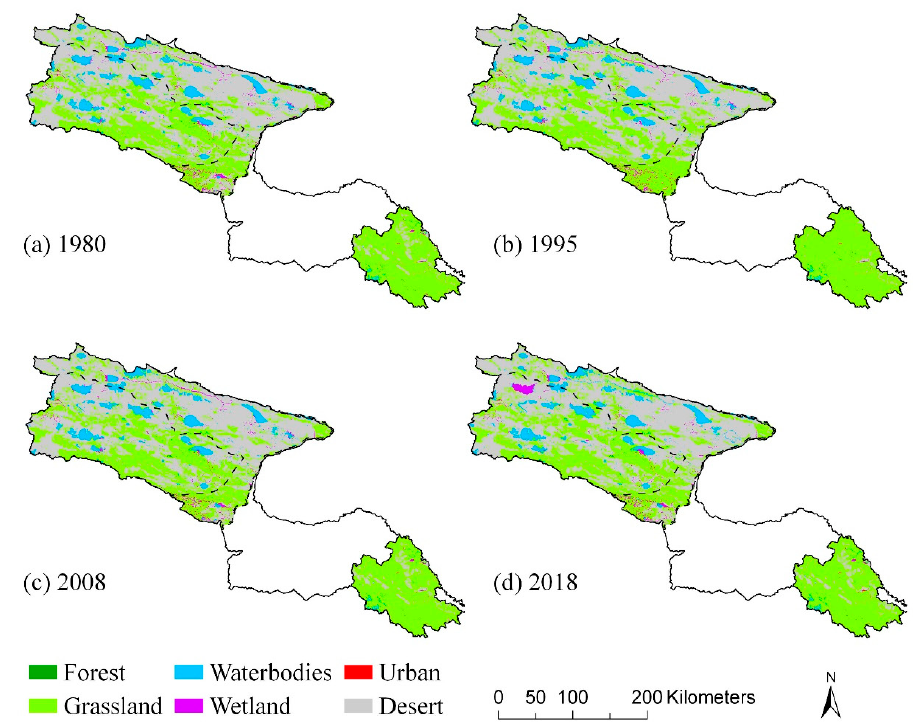
Figure 2. Comparison of land use / land cover pattern in the Hoh Xil Nature Reserve and the control area for ( a ) 1980, ( b ) 1995, ( c ) 2008, and ( d ) 2018. During the period 1980–2018, the areas of grassland, wetland, and waterbodies in the HXNR increased significantly by 293.36 km 2 , 110.43 km 2 , and 37.42 km 2 , respectively, with the SLUDD of 0.05%, 0.03% and 0.44% (see Table 3). Meanwhile, the SLUDD of the desert in the HXNR is − 0.05%, with a total reduction of 441.22 km 2 . In contrast, the grassland in the control area had been reduced considerably, which diminished by 99.35 km 2 (the SLUDD was − 0.03%) from 1980 to 2018. The urban having the SLUDD of 0.24% and 19.08%, respectively. Table 3. Land use dynamics in the study area during 1980–2018 and for different periods before and after the establishment of the HXNR.